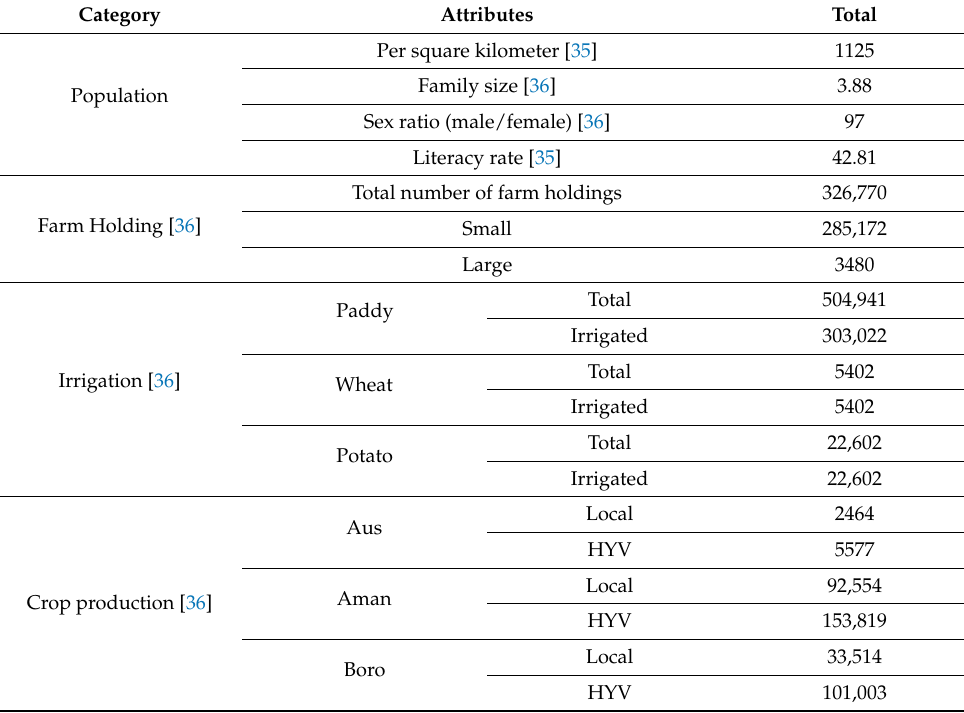
Table 1. Socioeconomic characteristics important for livelihood activities in Gaibandha. Source